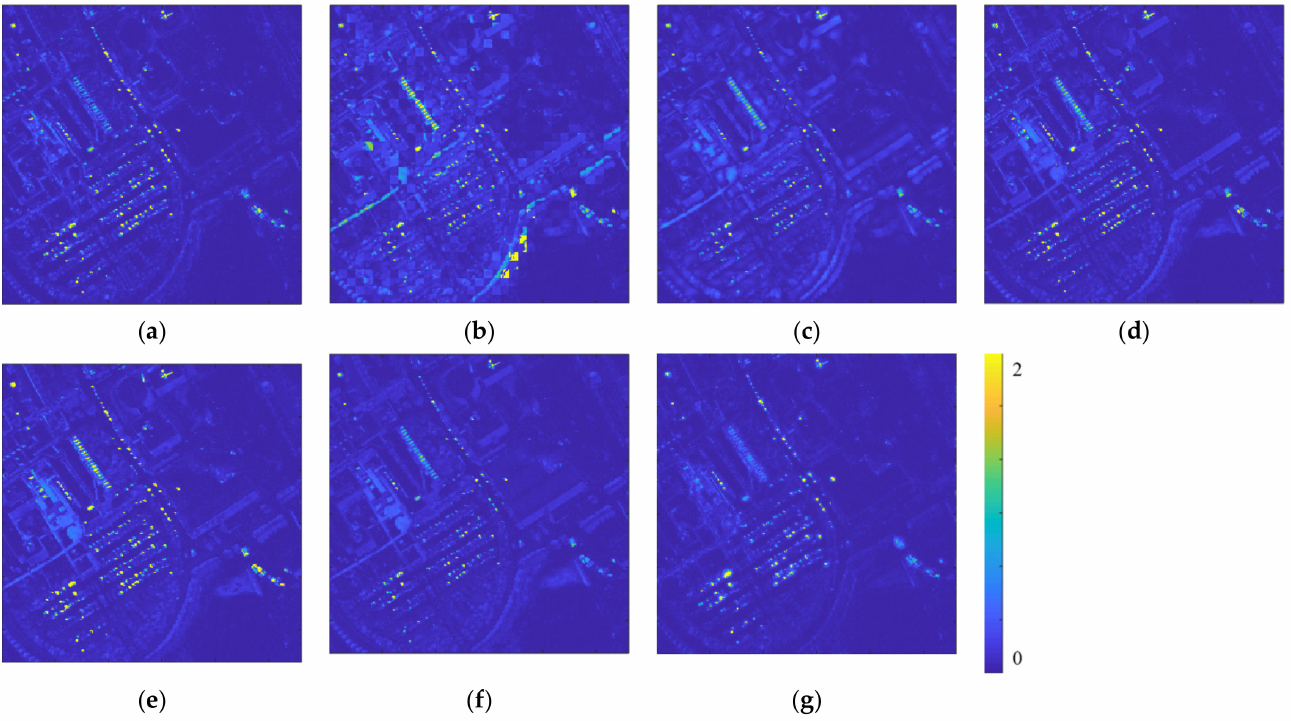
Figure 5. Residual information of Pavia University dataset with simulated multispectral images. ( a ) results of GSA; ( b ) results of SFIMHS; ( c ) results of GLPHS; ( d ) results of CNMF; ( e ) results of ICCV15; ( f ) results of HySure; ( g ) ours